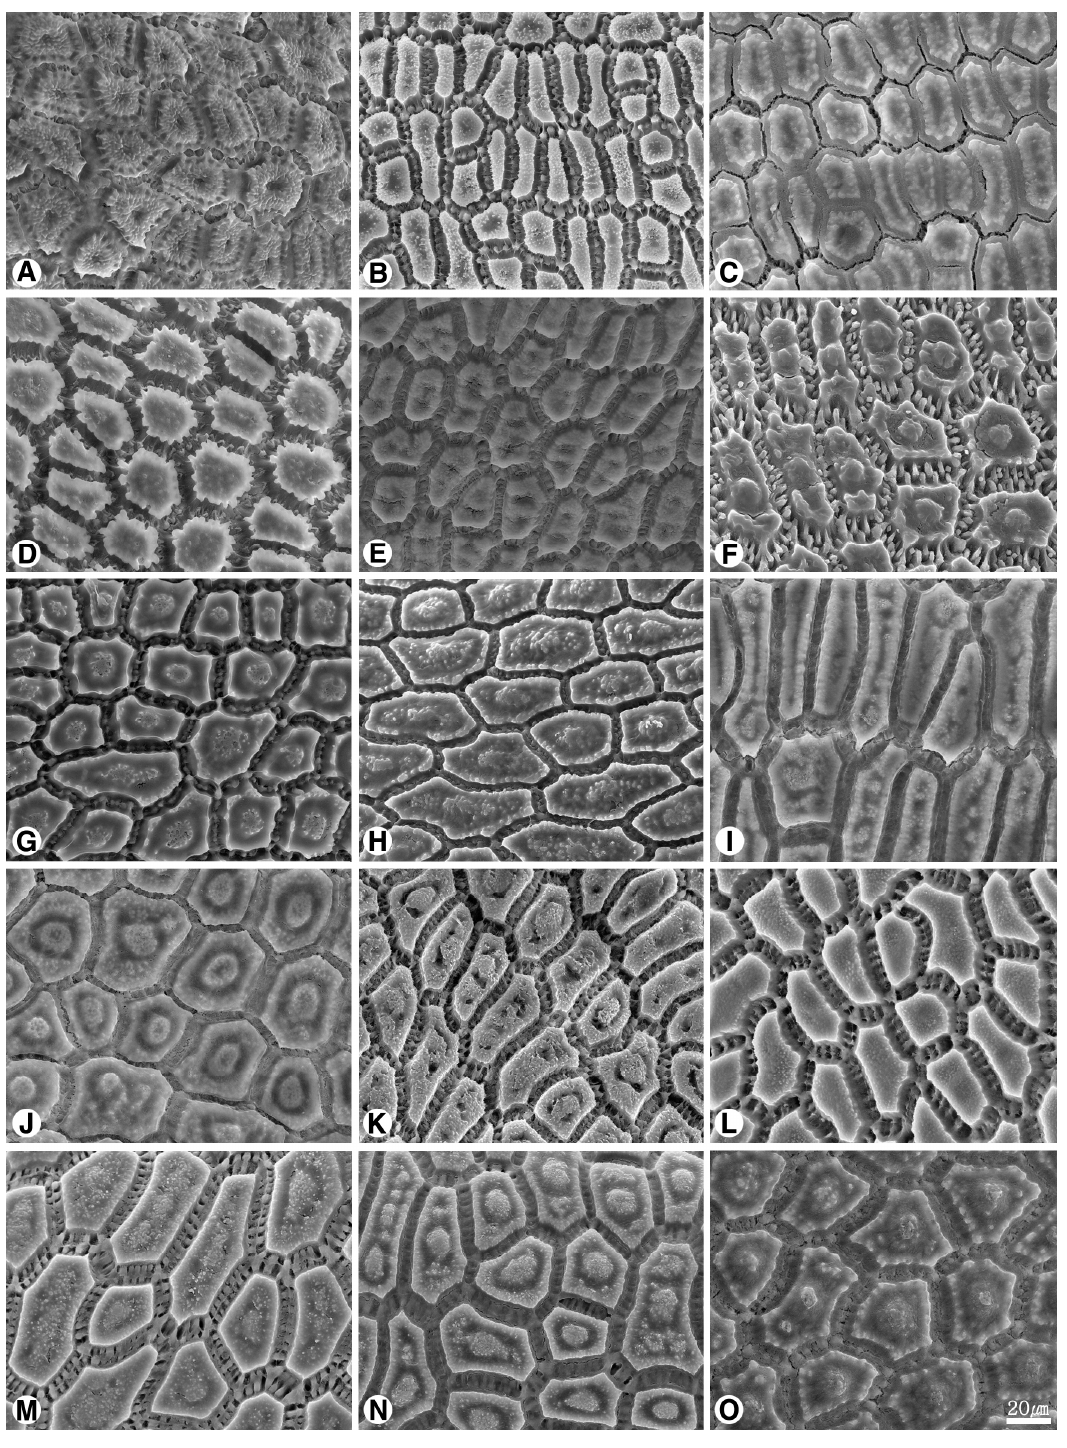
Figure 7. Scanning electron micrographs of seed testa in Allium . A – E subg. Polyprason : A A. korolkowii (sect. Falcatifolia ); B A. kirilovii ; C A. obliquum ; D A. petraeum ; E A. tianschanicum (sect. Oreiprason ); F – O subg. Reticulatobulbosa : F A. barsczewskii ; G A. dolichostylum ; H A. jodanthum (sect. Campanulata ); I A. amphibolum “136a”; J A. amphibolum “136b”; K A. clathratum ; L A. leucocephalum ; M A. malyschevii ; N A. strictum (sect. Reticulatobulbosa ); O A. trachyscordum (sect. Scabriscapa ).